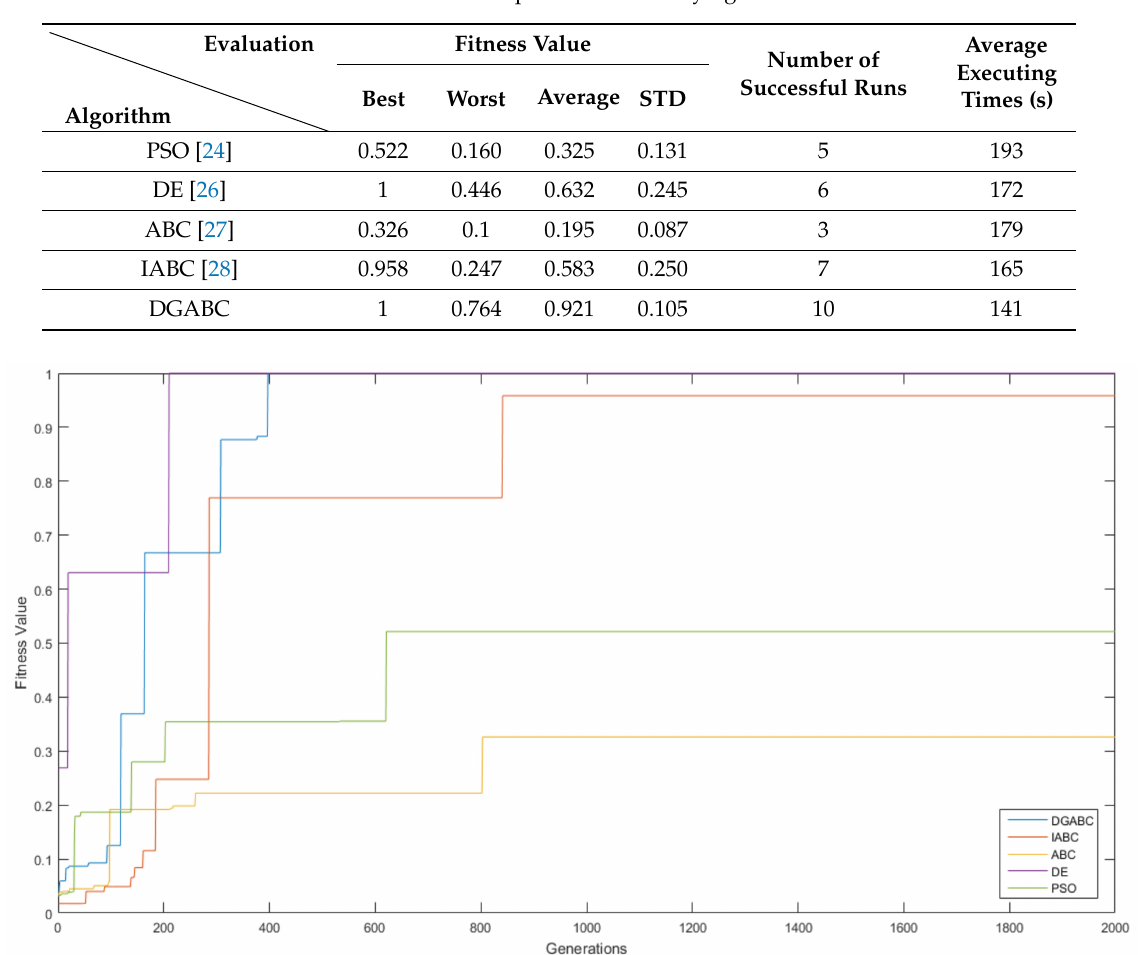
Table 4. Performance of cooperative load-carrying WFM control.